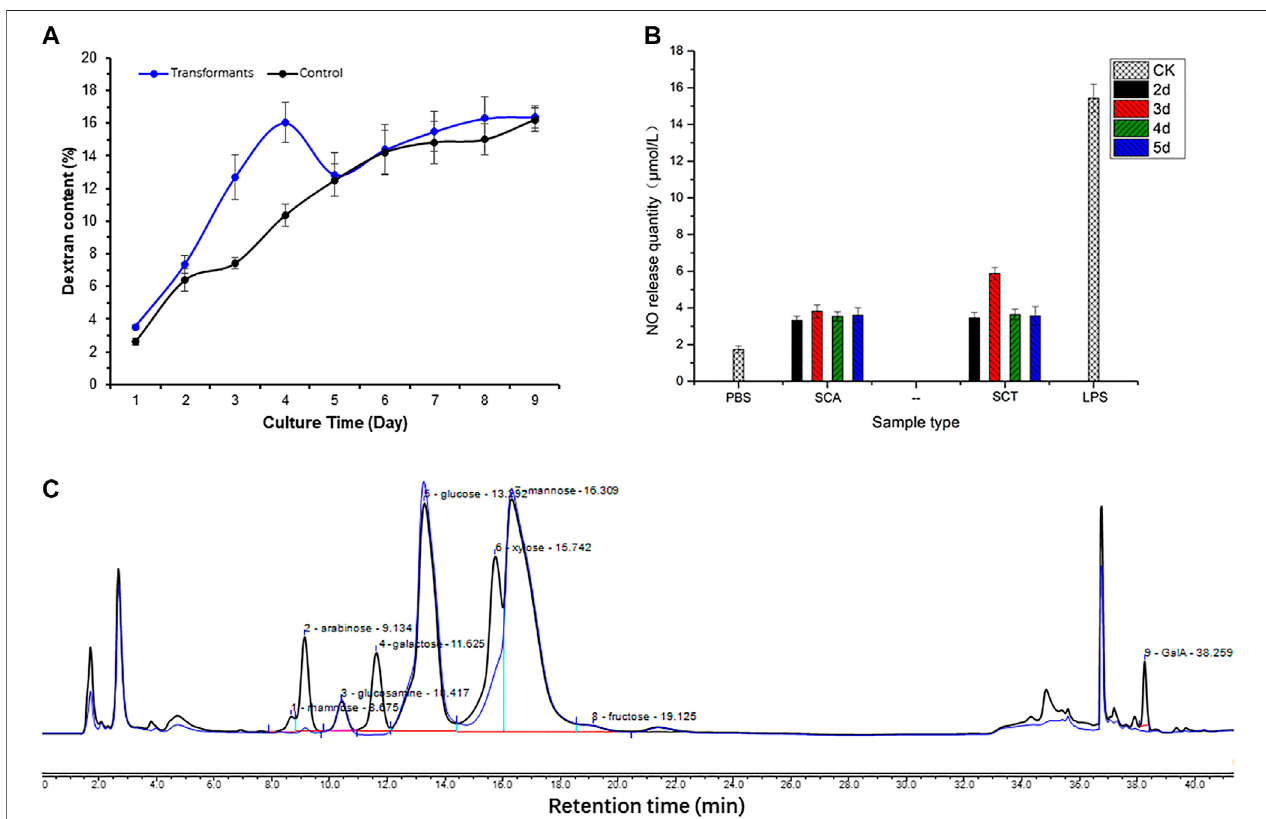
FIGURE6| Effect onpolysaccharide afterexpressing A6180inyeast. (A) Thetrendofglucanin S.cerevisiae controlgroupandtransformationgroup.Theresultof the control group is a blue curve and the result of the transformation group is a black curve. (B) Monosaccharide composition results of S. cerevisiae control group and transformation group on day 3. The result of the control group can be seen in the blue curve, and the result of the transformation group is present in the black curve. (C) Immune activity of polysaccharides from S. cerevisiae control group and transformation group. PBS (phosphate-buffered saline): blank control; SCT: polysaccharides from S. cerevisiae control group; SCA: polysaccharides from S. cerevisiae transformation group; LPS (Lipopolysaccharides): positive